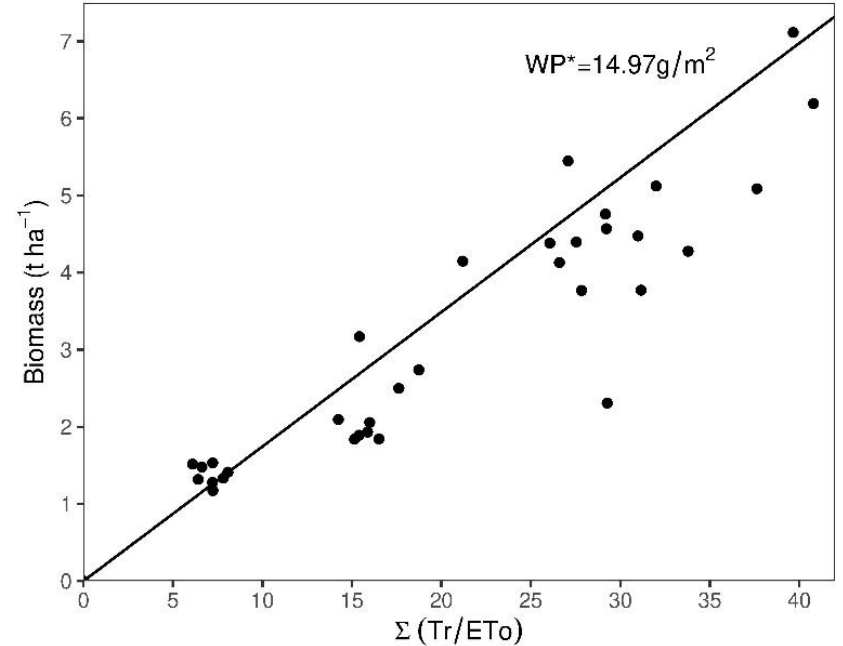
Figure 2. Cumulative biomass (normalized for CO 2 ) and cumulative transpiration (normalized for ET 0 ) for the ryegrass ( Lolium perenne L.) fields (black dots). Black line represents the WP* of 14.97 g/m 2 .